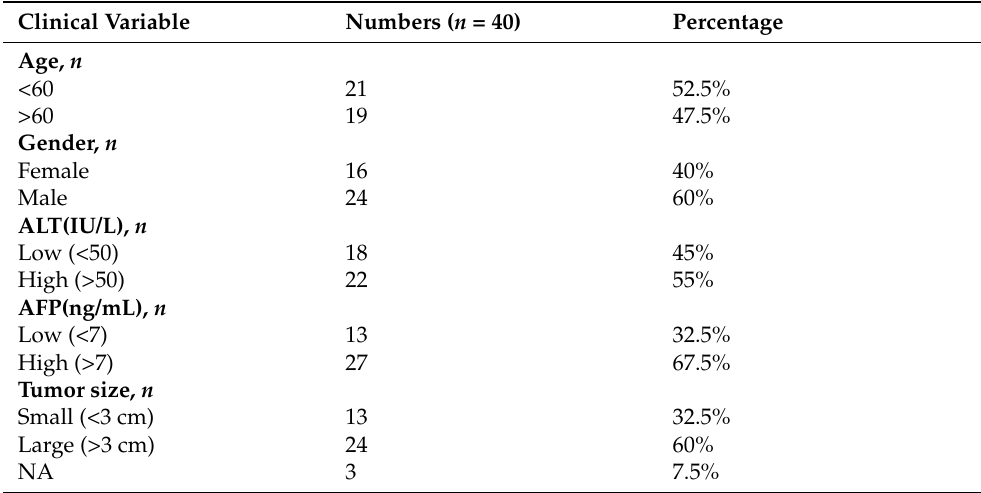
Table 1. The clinical features of patients in the serum samples recruited for this study.